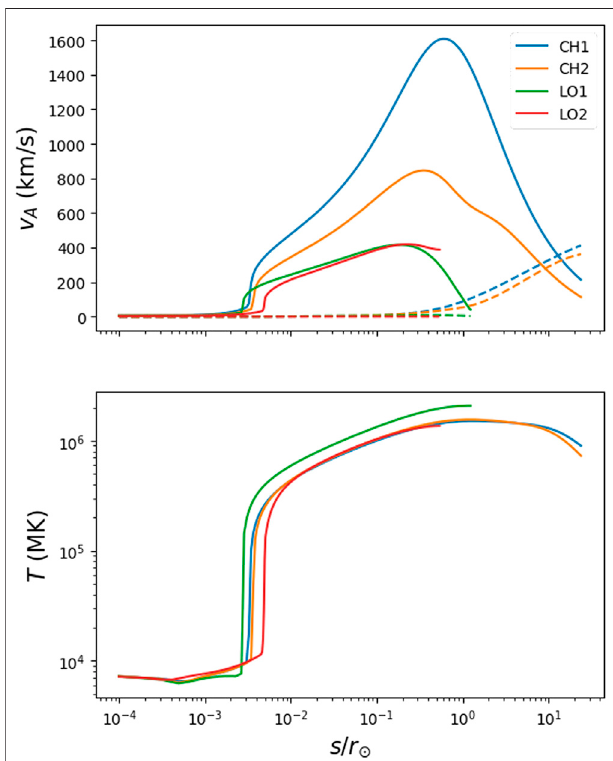
FIGURE2| Pro fi lesoftheAlfvénspeed, fl owspeed(indashed lines)and temperature for the four fi eld lines extracted from the simulation, along the curvilinearabscissa s .Forloops,weonlyshowonesideuptotheapex.These pro fi leswillbethesourceoftheampli fi cationandre fl ection(particularlyin open regions) of perturbations, the latter leading to the creation of counter- propagating perturbations. Non-linear interactions between counter- propagating waves create the cascade and the dissipation at small scales.